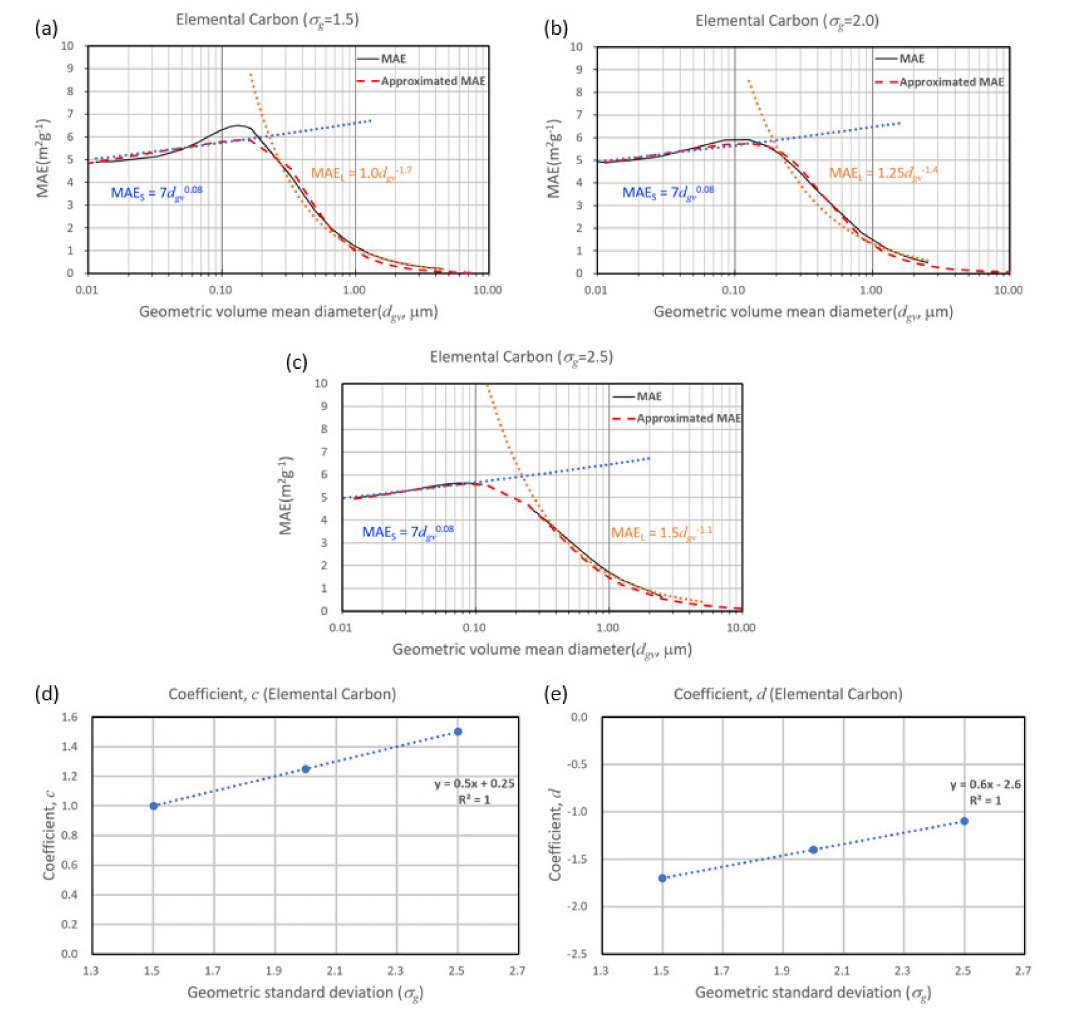
Figure 7. Comparison between the Mie theory-based calculation of mass absorption e ffi ciency (MAE, solid black lines) and the approximated MAE (long-dashed red lines) of elemental carbon for geometric standard deviations ( σ g ) of ( a ) 1.5, ( b ) 2.0, and ( c ) 2.5. The approximated mass extinction e ffi ciency in each panel is calculated based on the MAE S (dotted blue line) and the MAE L (dotted orange line) in each panel using Equation (5). The determined coe ffi cients c and d of MAE as a function of geometric standard deviation in Equation (6) for elemental carbon are shown in panel ( d , e